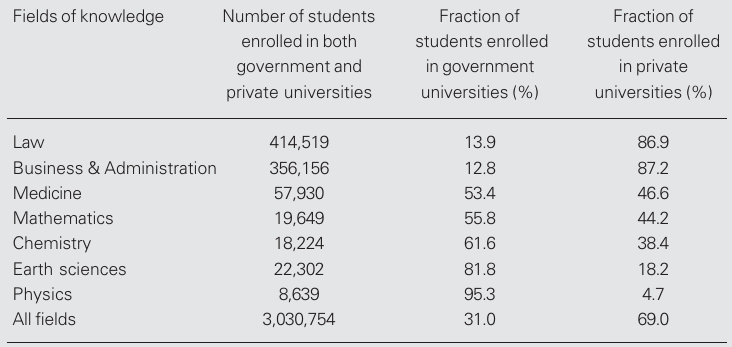
Figure 4. Evaluation of gradu- ate courses in Brazil in 2001 in government (open circles) and private universities (filled circles). A total of 1,544 gradu- ate courses were rated from level 1 to 7 by CAPES (Coorde- nação e Aperfeiçoamento de Pessoal de Nível Superior), in- cluding 1,343 from govern- ment and 201 from private uni- versities. Source: CAPES.